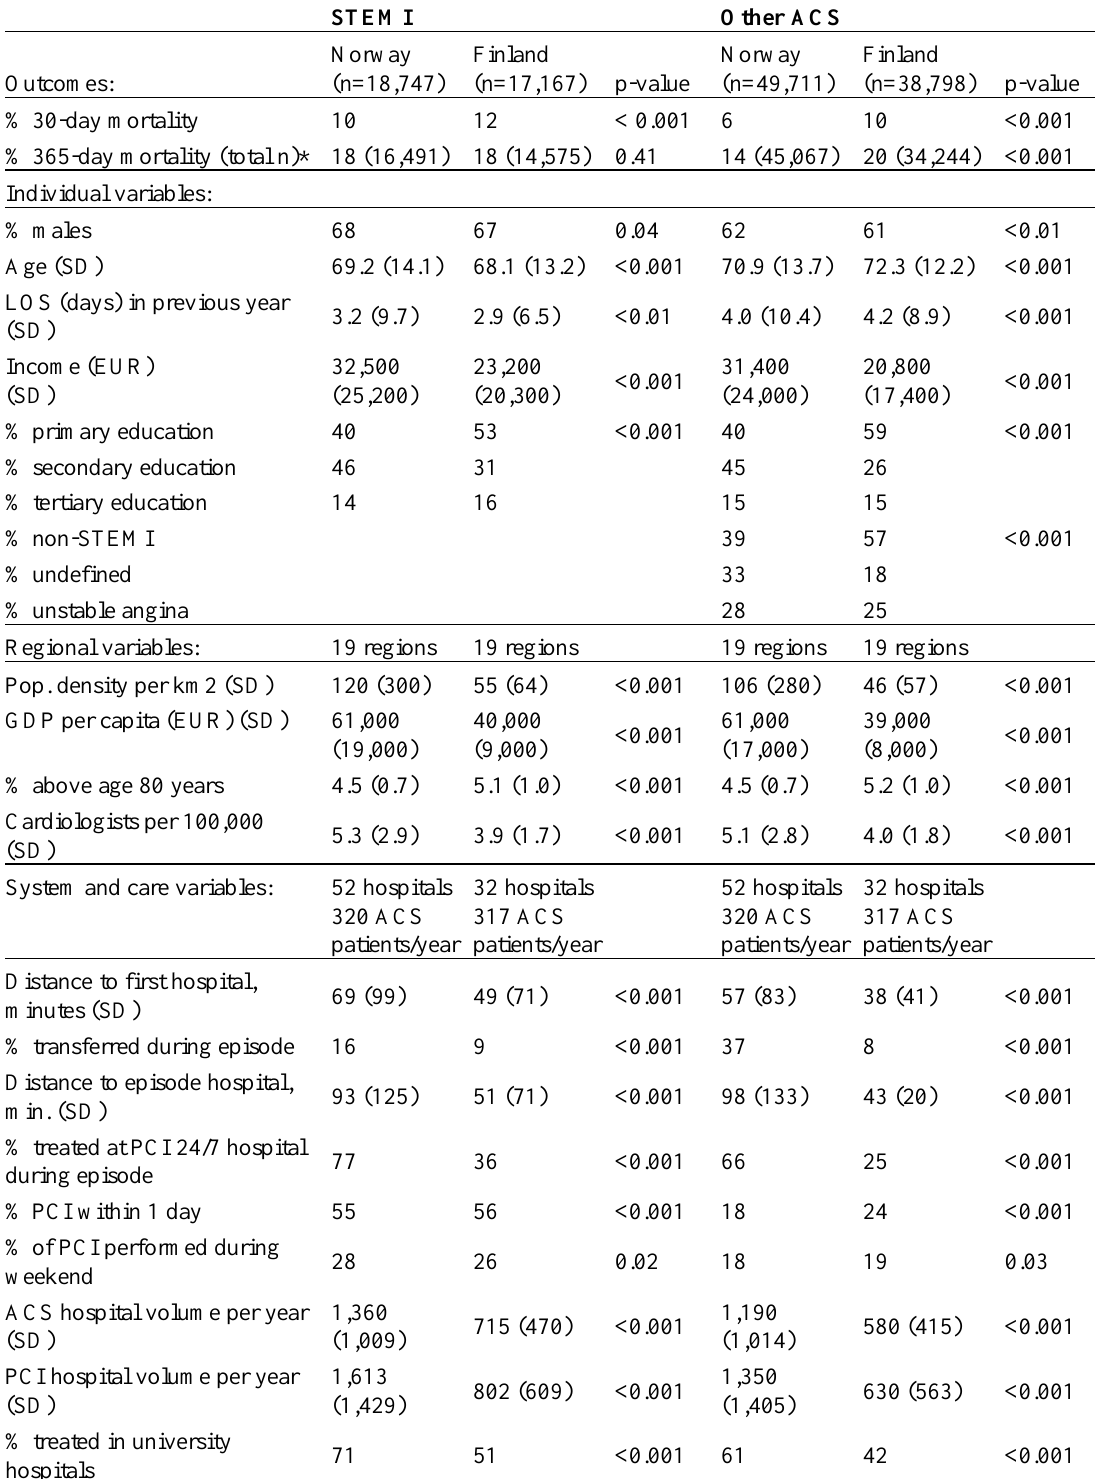
Table 1: Descriptive statistics for the STEMI and other ACS patients (non-STEMI, undefined AMI, and unstable angina pectoris)